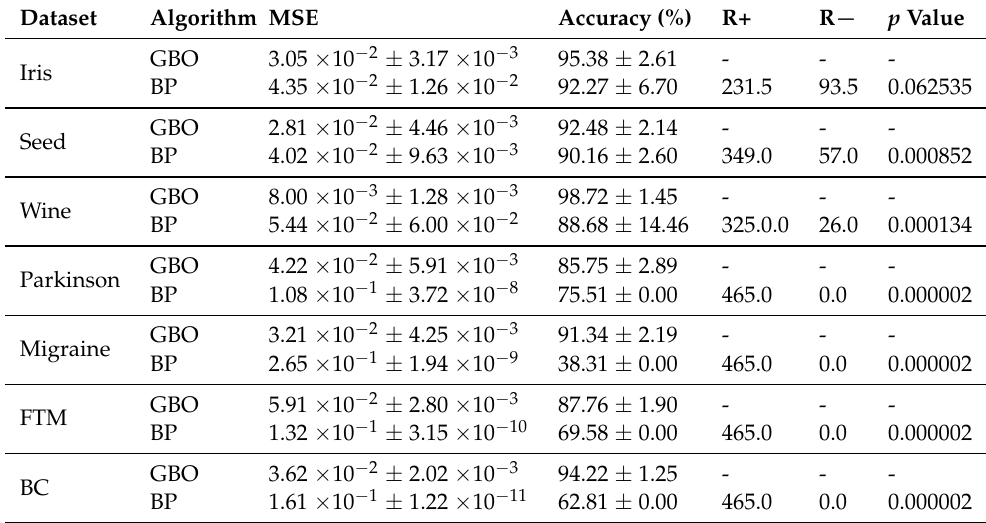
Table 2. Comparison results of the GBO algorithm and BP algorithm on the seven